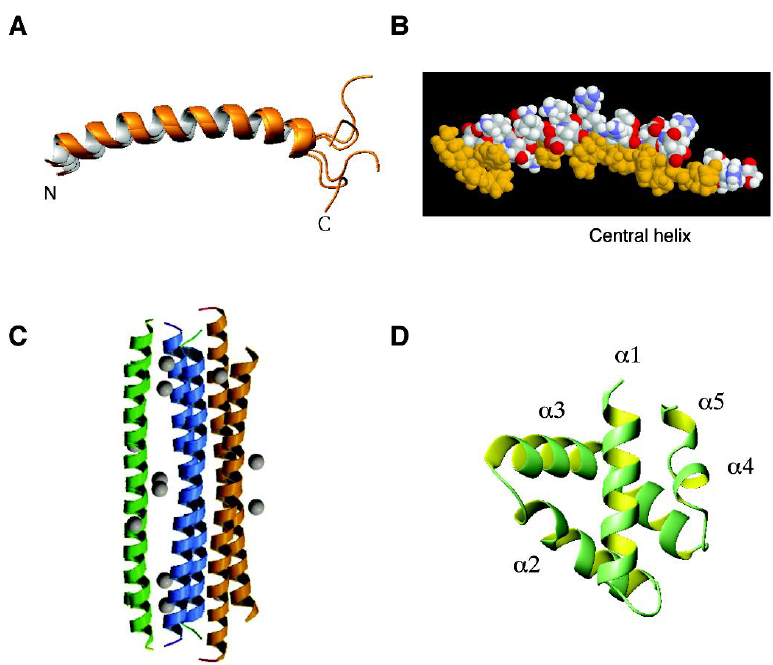
Figure 1. Three-dimensional structures of human antimicrobial peptides from the α-helical family: ( A ) and ( B ) human cathelicidin LL-37 determined by NMR spectroscopy (PDB ID: 2K6O); ( C ) dermcidin determined by X-ray crystallography (PDB ID, 2YMK); and ( D ) granulysin determined by X-ray diffraction (PDB ID: 1L9L). In the case of LL-37, an ensemble of five structures is shown to better view the disordered C-terminal tail (A), (gold) into two domains (B) [182]. The longer one corresponds to the central helix which